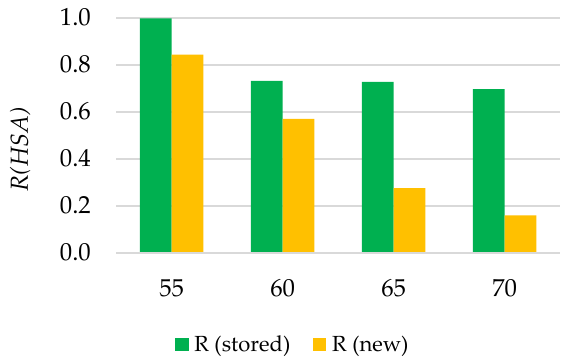
Figure 12. Reliability as a function of measured hardness for new (recently manufactured when measured) and stored O-rings.